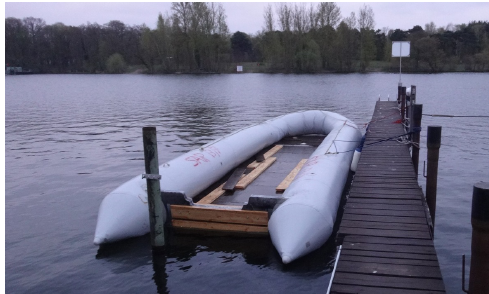
Figure 1. The inflatable rubber boat used for this study. (Source: Peter